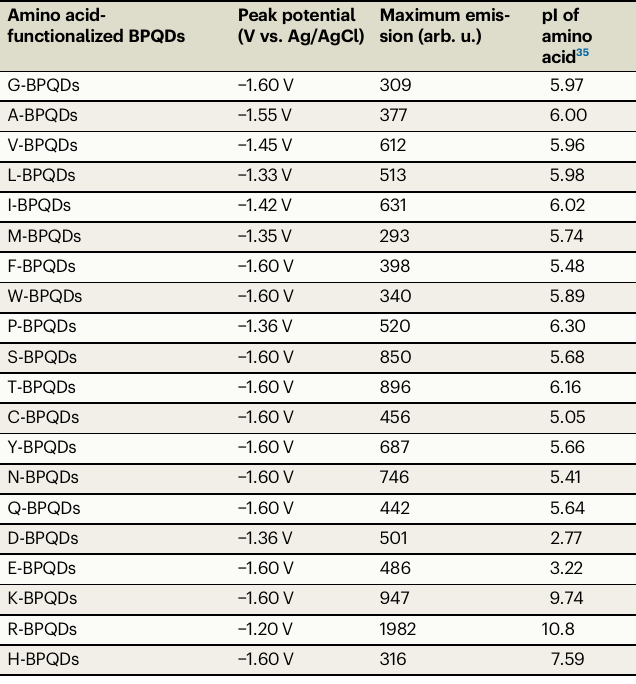
Table 1 | ECL responses of GCEs modi fi ed with 20 kinds of amino acid-functionalized BPQDs in 0.1 M pH 7.4 PBS con- taining 0.1 M K 2 S 2 O 8 and pIs of corresponding amino acids Amino acid- functionalized